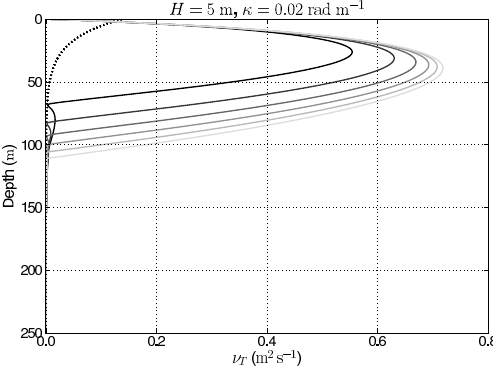
Fig. 5. Turbulent viscosity due to non-breaking wave-induced tur- bulence for a wave height of 5m and a wave number of 0.02rads − 1 . The dotted line is the constant-in-time B v parameterisation, while the solid lines are calculated from the parameterisation based on wave dissipation (Babanin, 2011) using the k – (cid:15) model of Rodi (1987). The darkest line is that calculated two hours after the simu- lation started, with subsequent two-hour intervals indicated by pro- gressively lighter